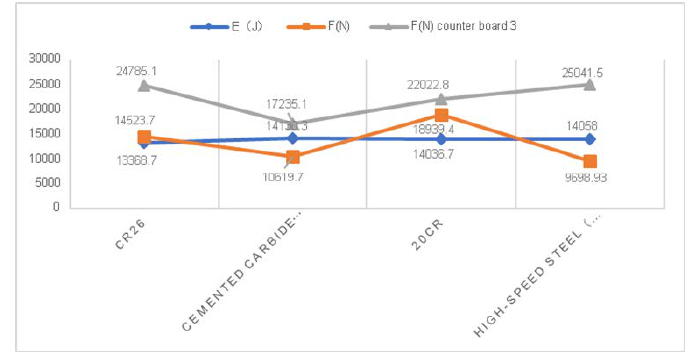
Fig. 17 The materials of counter